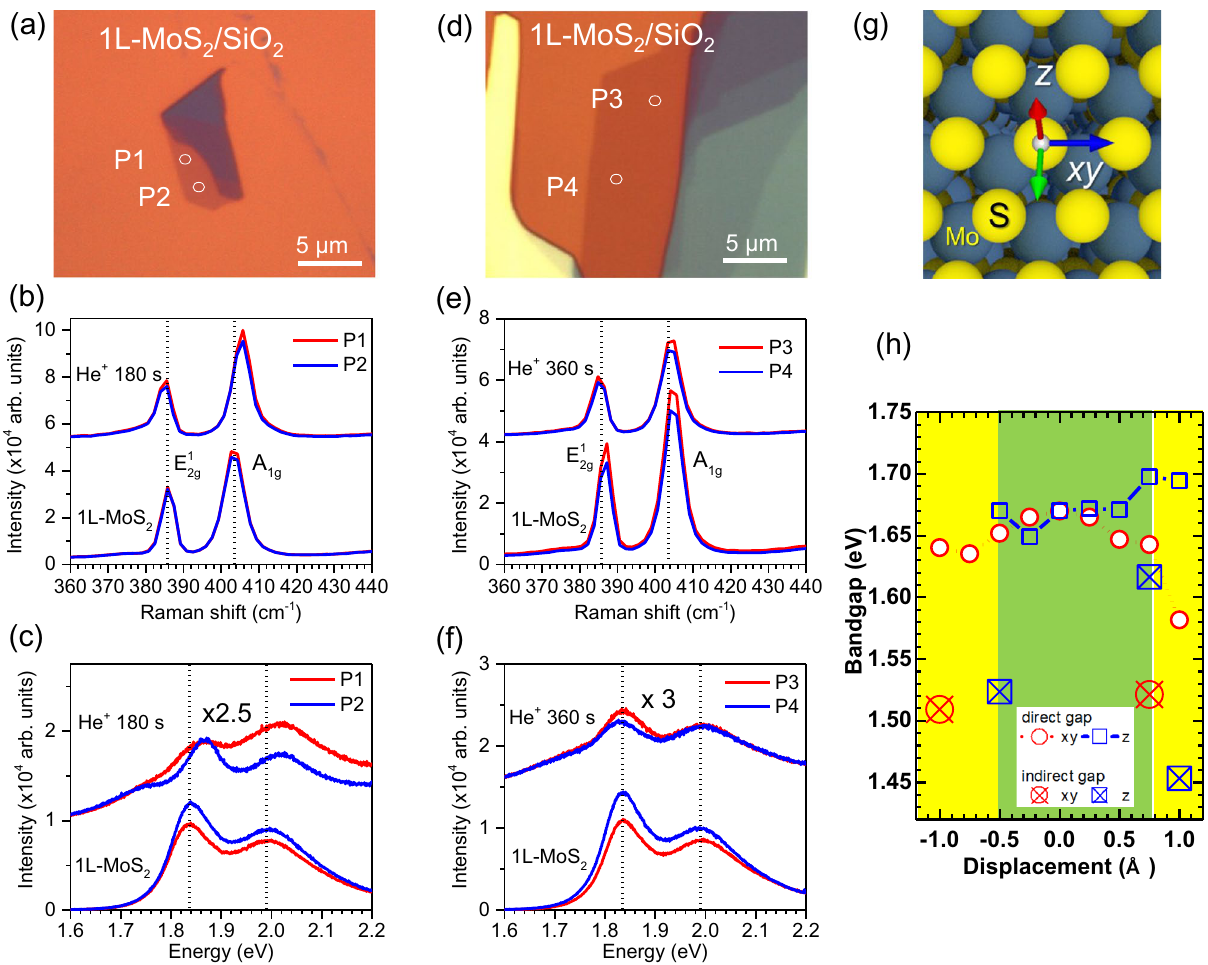
Figure 5. ( a , d ) Optical microscope images of the mechanically exfoliated MoS 2 flakes on the SiO 2 /Si substrates. Comparison of Raman ( b , e ) and PL ( c , f ) spectra of 1L-MoS 2 samples before and after He + ion irradiation for 180 s ( b , c ) and 360 s ( e , f ). ( g ) Schematic of available migrations for the S atoms before sputtering with He + ion irradiation. ( h ) Displacement dependence of the S atom on the direct bandgap energies of 1L-MoS 2